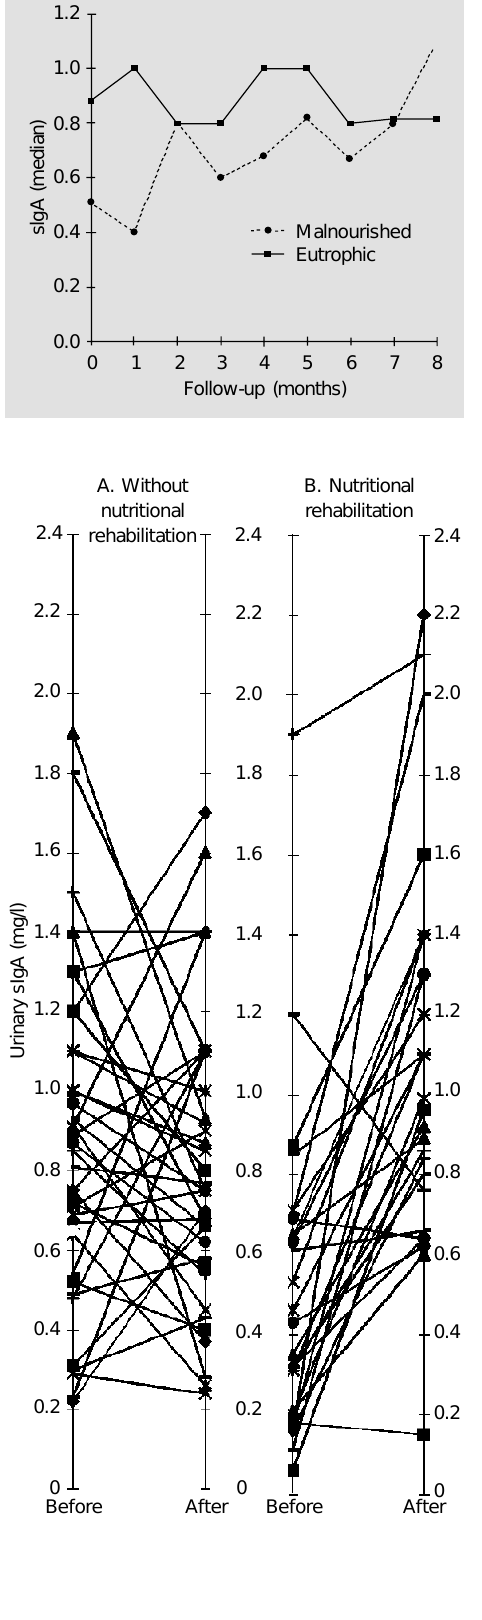
Figure 1 - Median urinary sIgA concentration of children aged 3 months to 5 years who were eutrophic or malnourished at the beginning of the 8-month follow-up, and with nutritional rehabilitation at the final evalua- tion. Data are reported as me- dian of urinary sIgA for 27 mal- nourished and 38 eutrophic chil- dren.